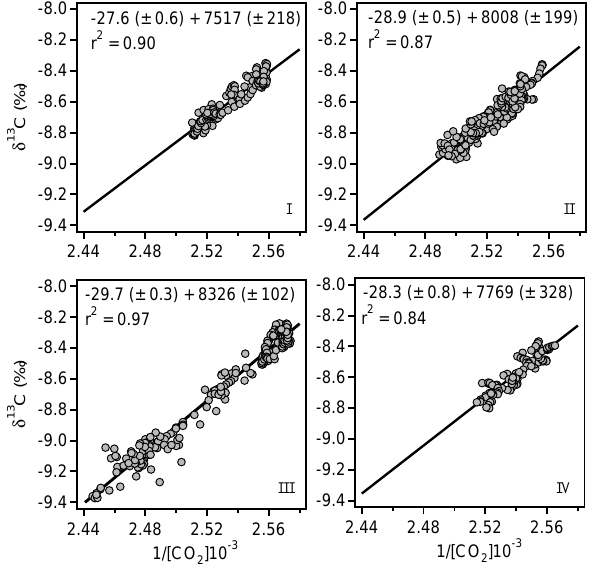
Fig. 6. Keeling plots for data collected during the individual pollu- tion events. δ 18 O values representing one hour aggregates are plot- ted against the inverse of CO 2 mixing ratio. The intercept and the slope of the ordinary least square linear regression is given together with their 1 σ